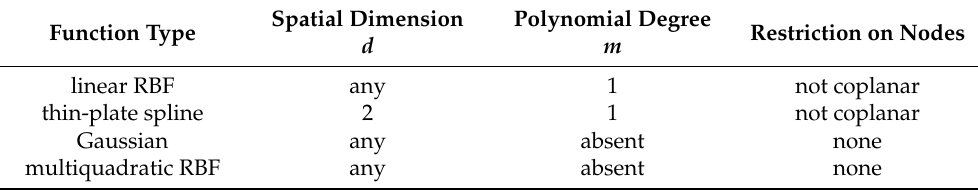
Table 2. Conditions imposed on nodes for various radial basis interpolants.